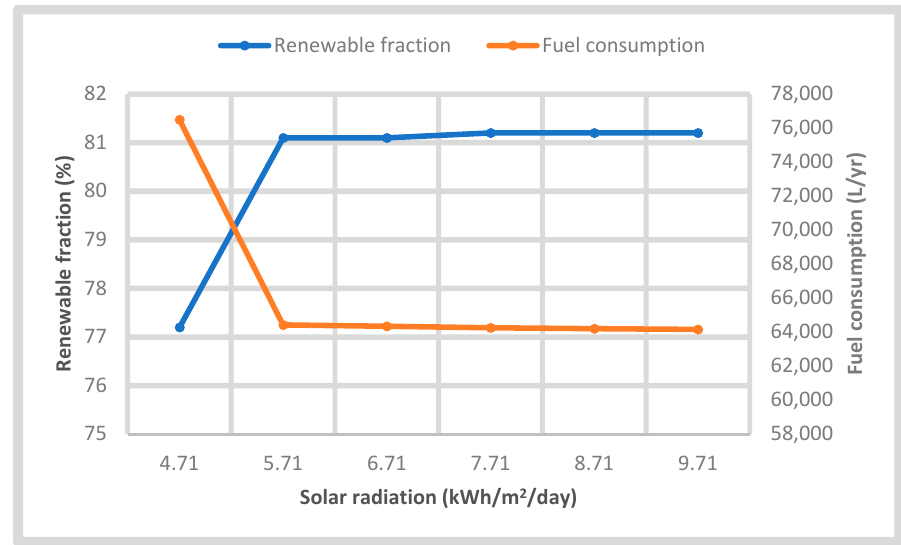
Figure 15. Impact of GSI on the renewable fraction and annual fuel consumption.